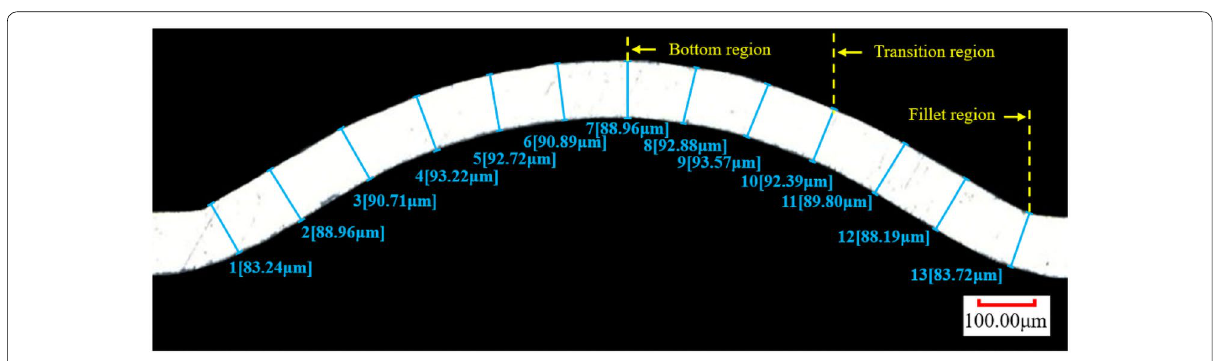
Figure 13 Thickness measurement of bulging parts